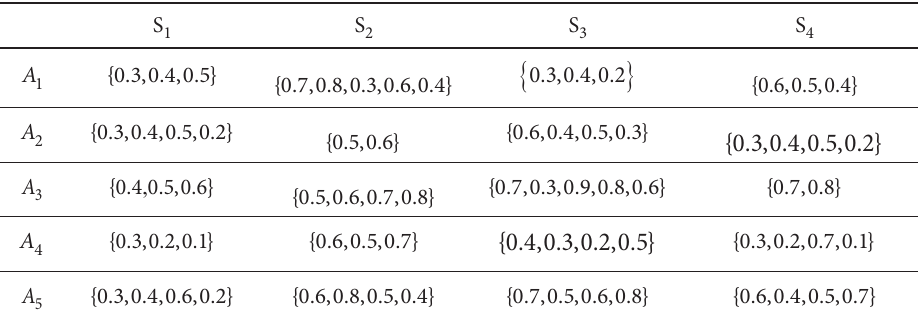
Table 6. Hesitant fuzzy decision